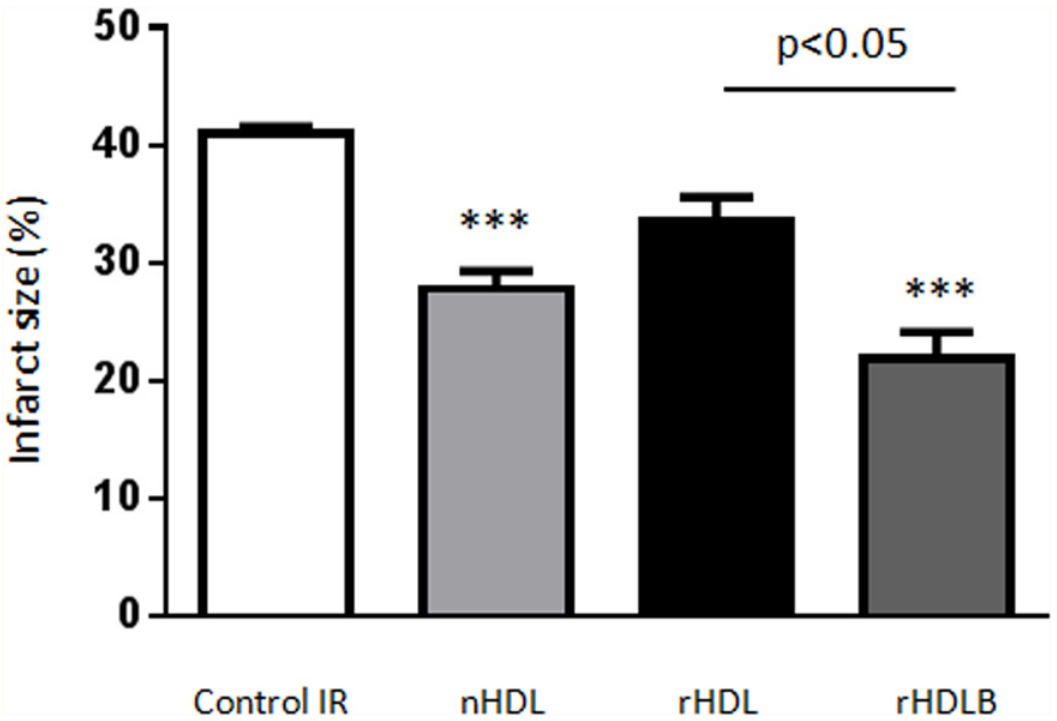
Fig 3. rHDL containing S1P protect against ischemia reperfusion injury ex vivo . Isolated hearts were submitted to global ischemia (35min) followed by reperfusion (45min). At the onset of reperfusion, hearts were treated or not (control) with native HDL (nHDL), rHDL (apoAI+POPC) or rHDLB (apoAI + POPC + S1P) during the first 7min. Infarct size is expressed as percentage of total heart area, (mean ± SEM). *** p < 0.001 vs control using one-way ANOVA combined with Tukey multiple comparisons post-hoc test, n (cid:2) 4.